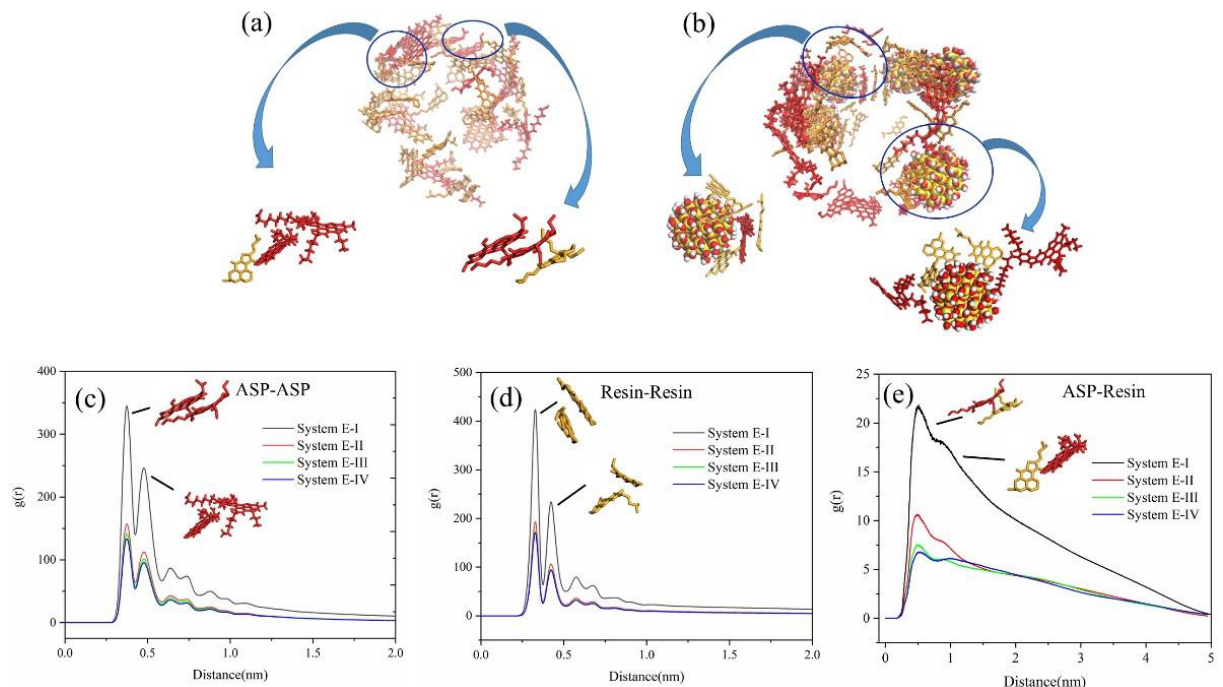
Figure 6. Distribution configurations of asphaltene, resin molecules and SNPs in System E-I ( a ) and System E-II ( b ). Radial distribution function (RDF) of four systems: asphaltene and asphaltene molecules to centroid ( c ), resin to resin ( d ), asphaltene to resin ( e ). Red, orange sticks represent asphaltene and resin molecules, respectively, spheres represent SNPs.